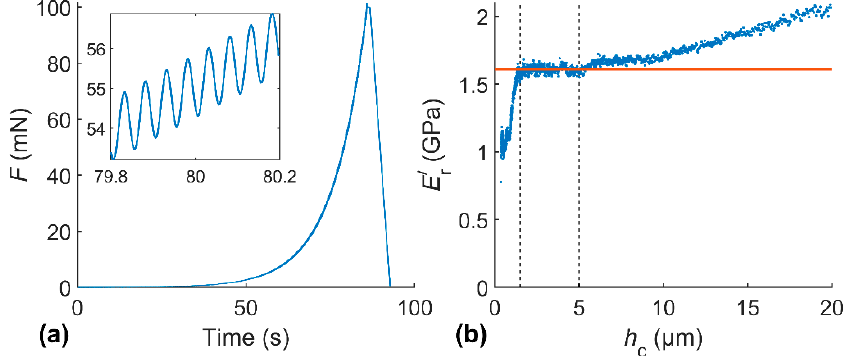
Figure 2. ( a ) CSM load function applied to a 0.2 mm-thick TiO 2 acrylic paint film on a glass substrate, and ( b ) the resulting reduced storage modulus versus contact depth, showing the effects of surface roughness and substrate stiffness below ~1.5 μ m and above ~5 μ m, respectively.